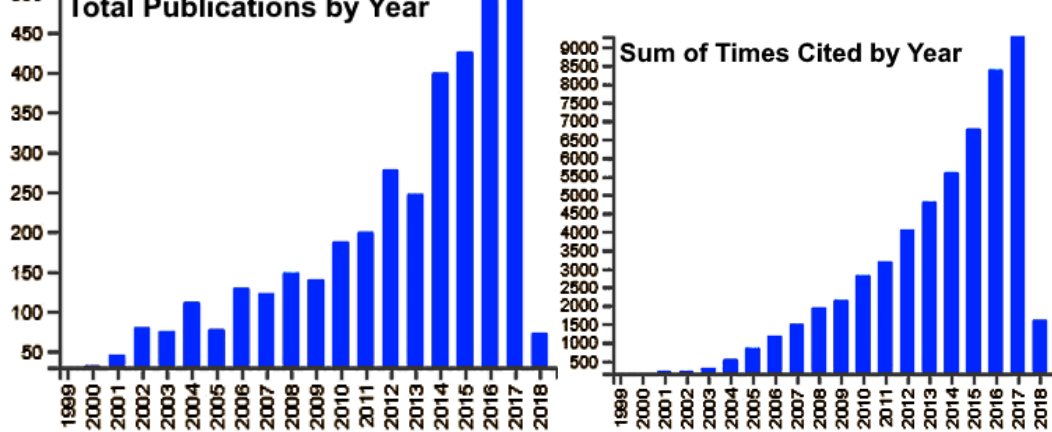
Figure 2. Publications and citation trends in Photonics (Source: Thomson Reuters Web of Science).